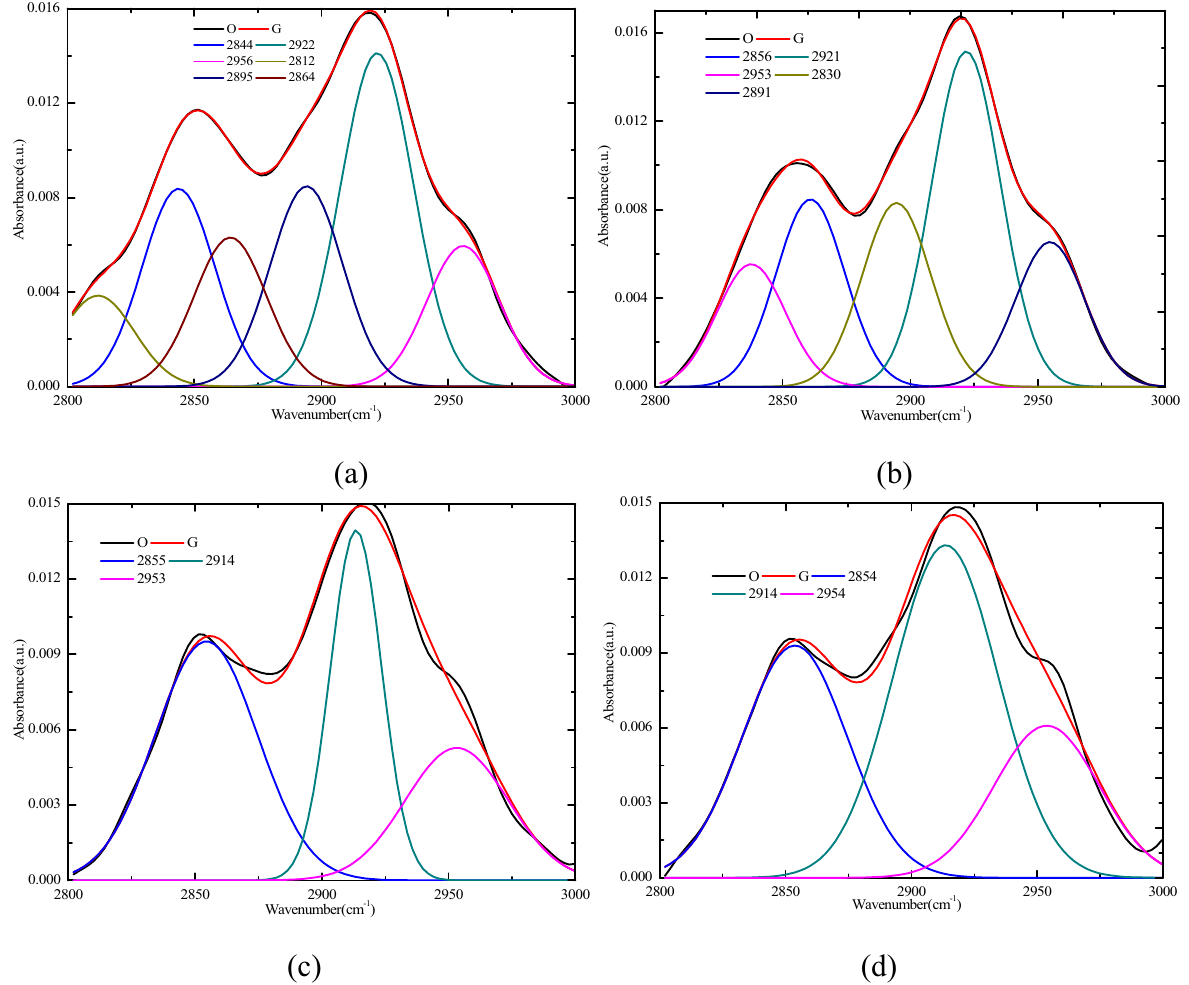
Figure 5. Fitted curve of FTIR spectrum ranging from 2800 to 3000 cm −1 . ( a ) R C , ( b ) Sad-8 h, ( c ) Sad-24 h, ( d ) Sad-48